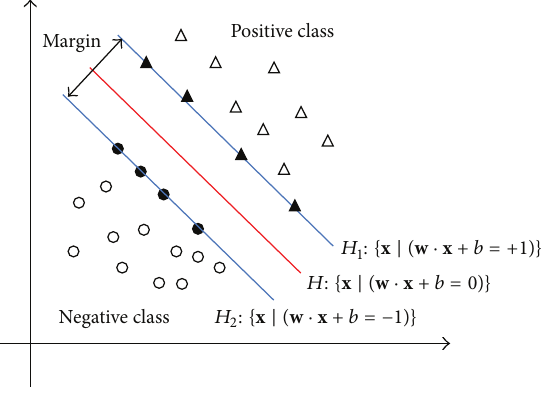
Figure 1: The diagram of SVM.